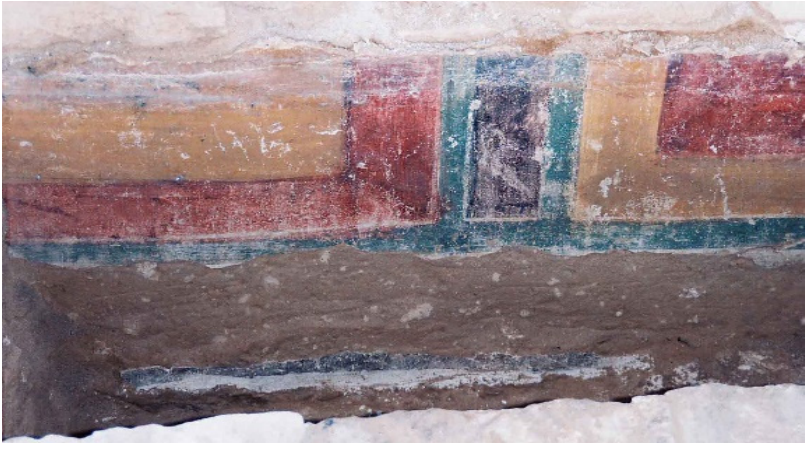
Figure 7. House H10a, painted wall decoration (photo Rafa ł Czerner).